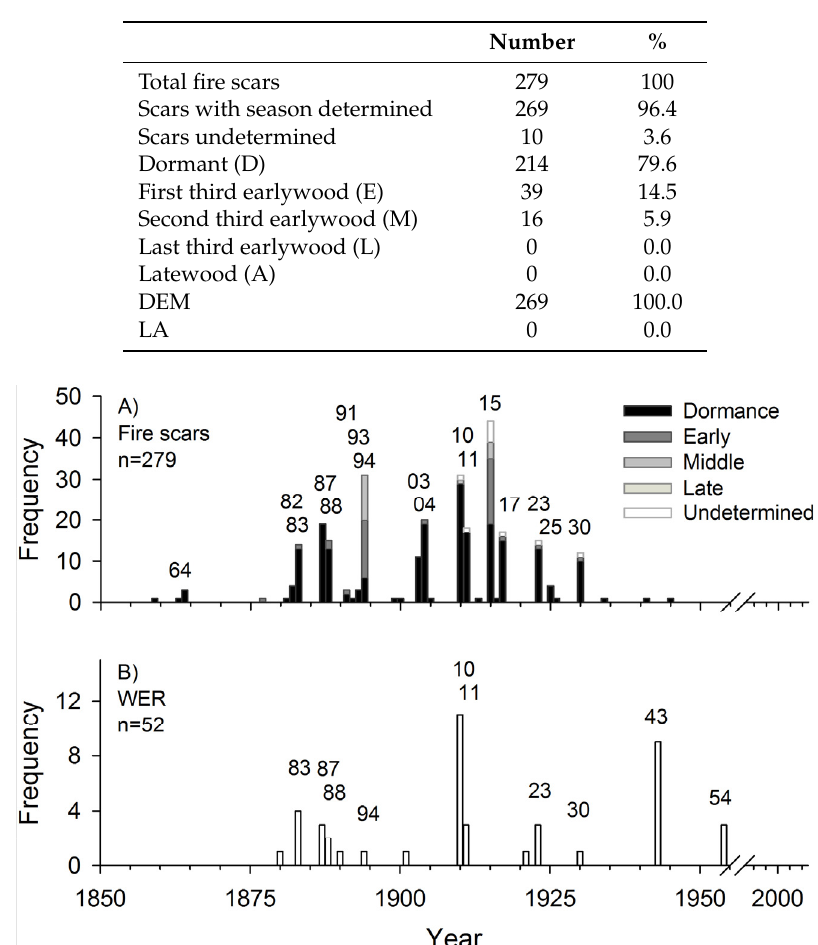
Table 2. Seasonality of fire scars based on relative intra ‐ annual position of fire scar within the annual growth rings.